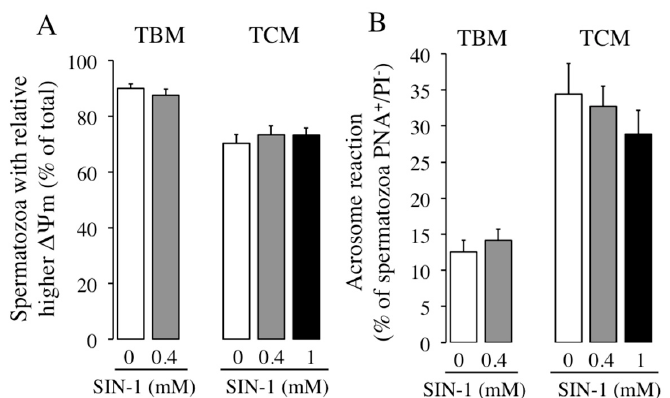
Figure 6. Effect of SIN ‐ 1 induced ‐ peroxynitrite in mitochondrial membrane potential and in the acrosome reaction induced by calcium ionophore A23187 on boar spermatozoa. Boar spermatozoa were incubated in TBM or TCM at 38.5 °C in the absence (white histograms) or presence of SIN ‐ 1 (filled histograms) for 1 h. ( A ) Results are expressed as the percentage of spermatozoa exhibiting relative higher ΔΨ m from the total sperm cells analyzed. ( B ) Percentage of live acrosome ‐ reacted spermatozoa (PNA + /PI − ) induced by A23187. These experiments were performed 8 times in A ( n = 8) and 7 times in B ( n = 7) and data are expressed as the mean ± SEM. No statistical differences were found ( p < 0.05).